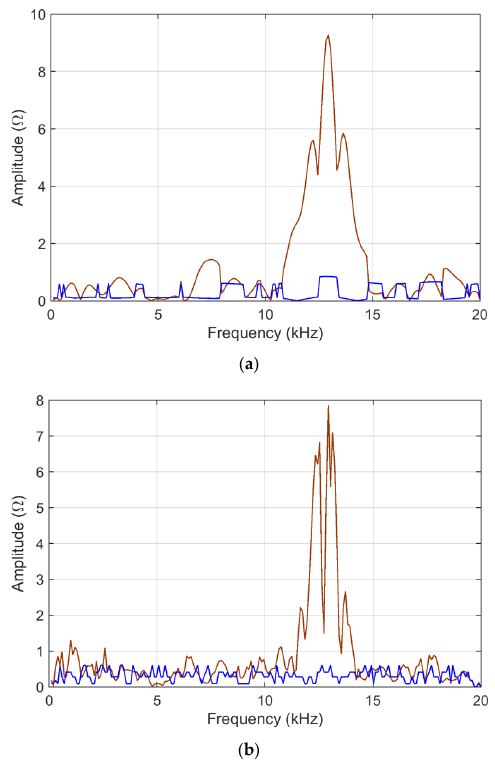
shown in Figures 4 and 5.